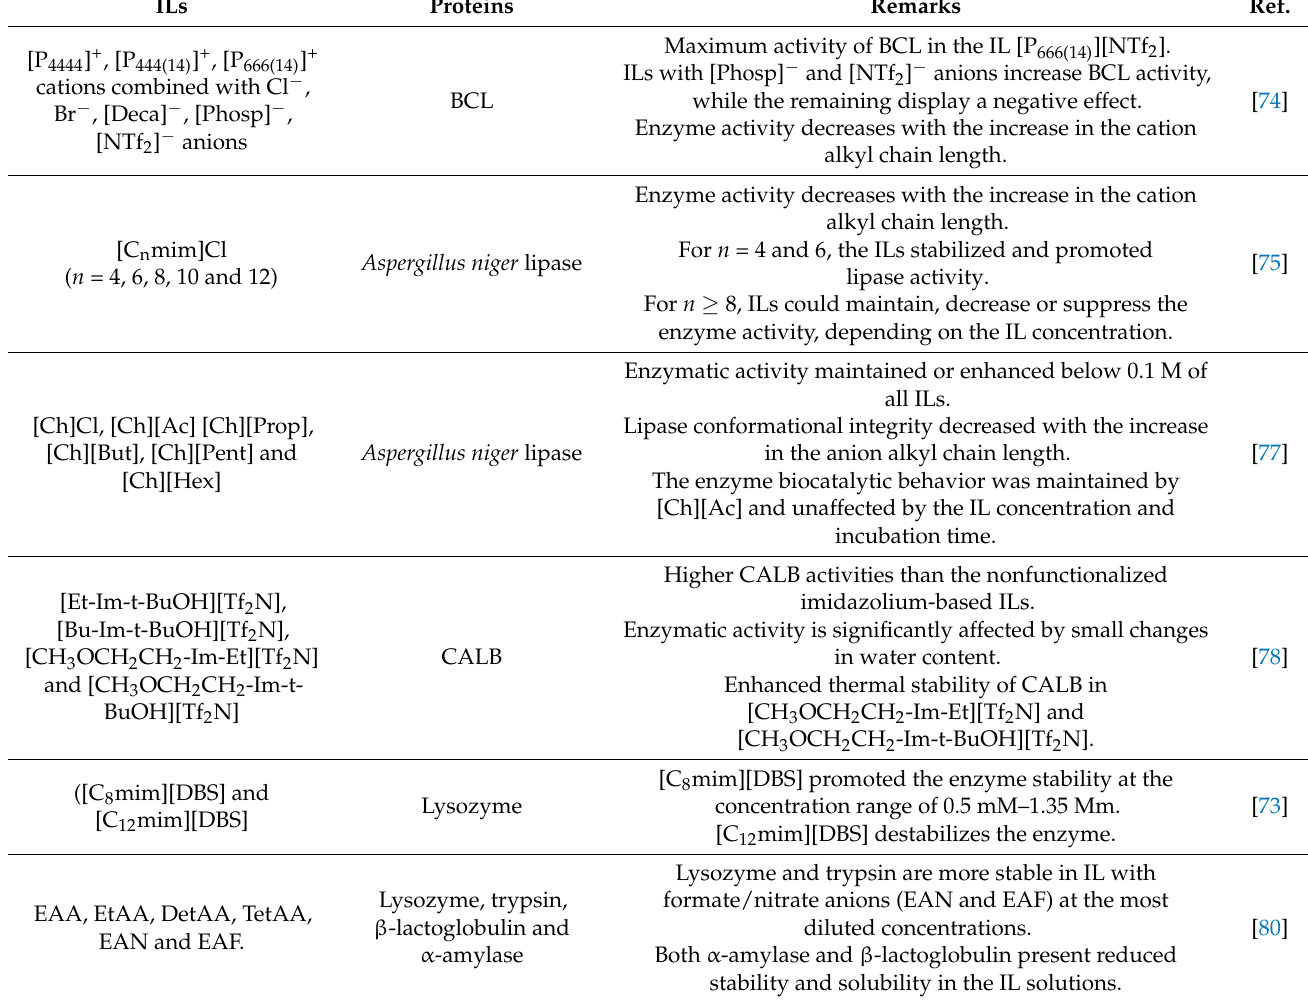
Table 2. Summary of the studies reviewed in this work reporting the stabilization of enzymes in ILs.